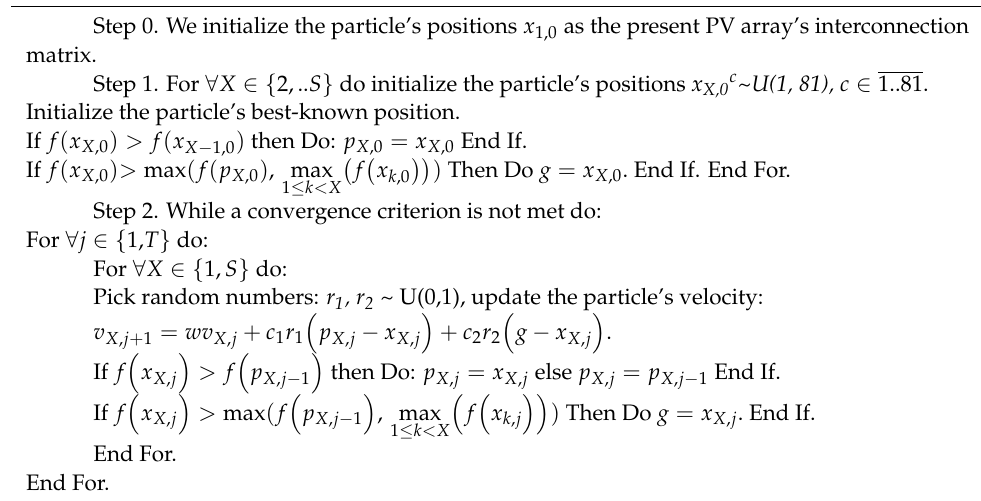
Algorithm 1. The TCT PV Array’ Reconfiguration Algorithm Based on